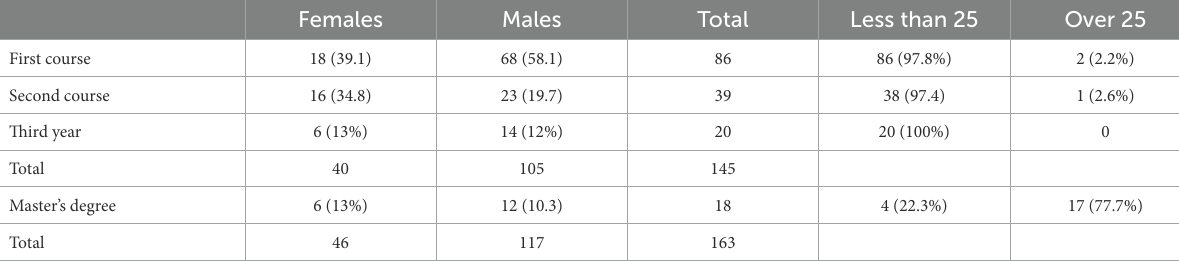
TABLE 1 Descriptive statistics on the characteristics of the sample.